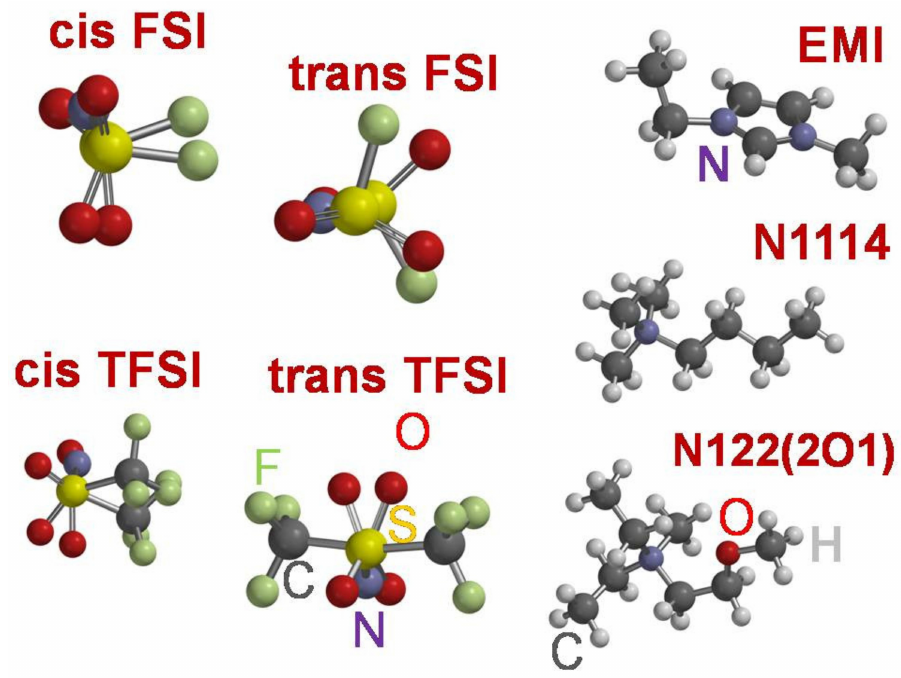
Figure 1. Schematics of the anion and cations investigated in the present